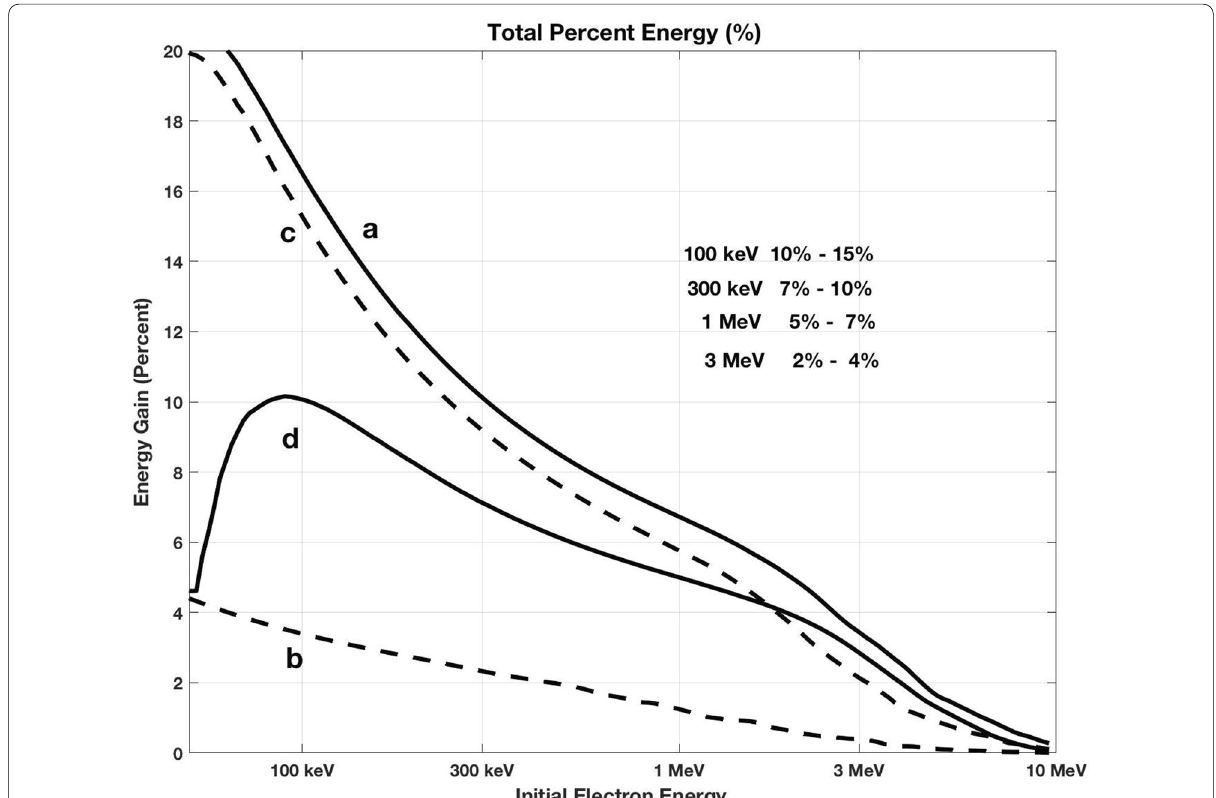
Fig. 7 Percent energy gain is shown for seed electrons with initial energies between 30 keV and 10 MeV trapped in a single nonlinear interaction with the first two subpackets of the chorus elements shown in Fig. 2 Panels a – d following the calculations of Omura et al.